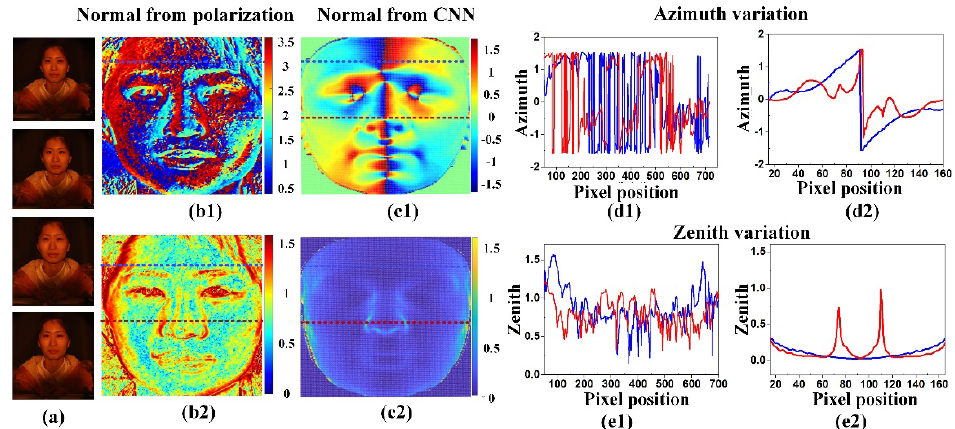
Figure 6. Surface normal data of the Chinese woman wearing no glasses; ( a ) four polarization intensity images; ( b1 , b2 ) azimuth and zenith derived from polarization; ( c1 , c2 ) azimuth and zenith derived from CNN-based 3DMM; ( d1 , d2 ) azimuth from polarization and CNN-based 3DMM variation along the red and blue lines; ( e1 , e2 ) zenith from polarization and CNN-based 3DMM variation along the red and blue lines.